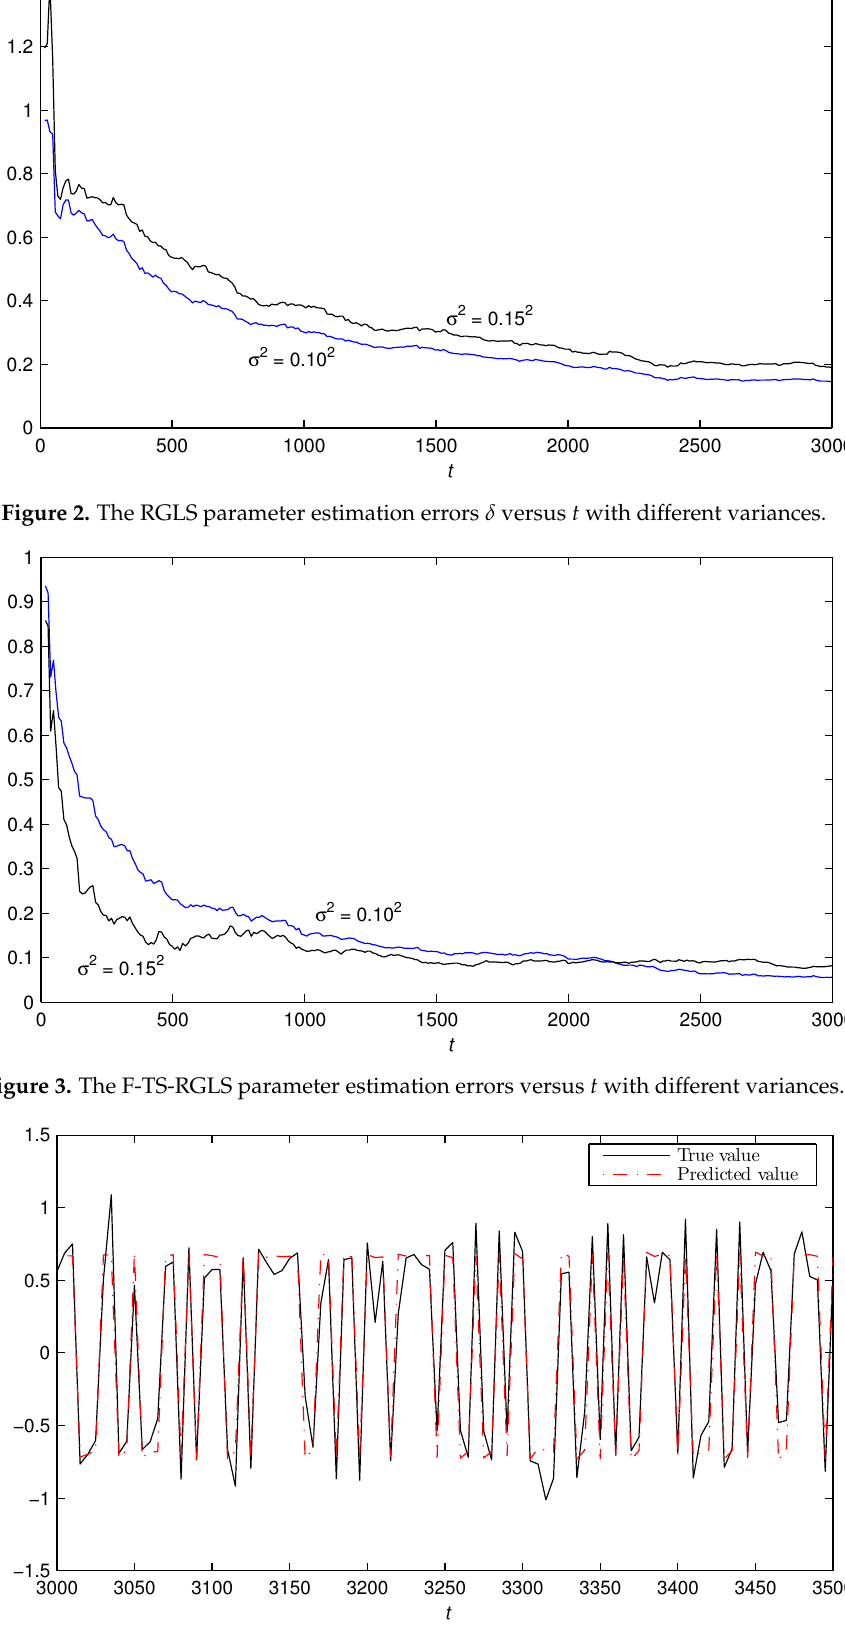
Figure 4. The true outputs and the RGLS predicted